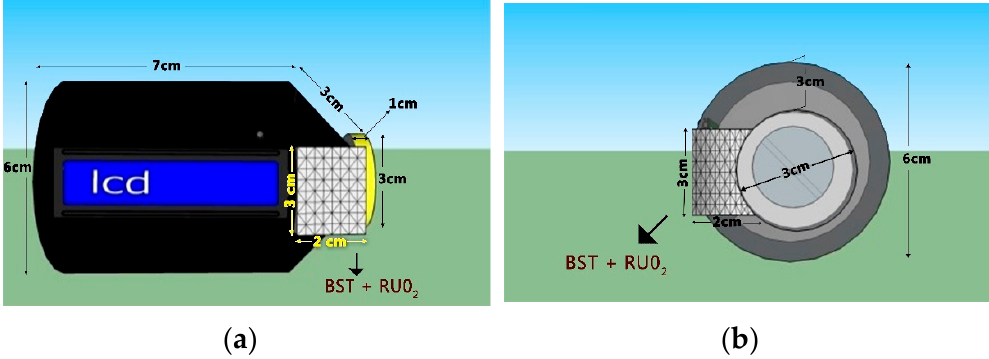
Figure 6. The prototype design: ( a ) front view; ( b ) Side view.